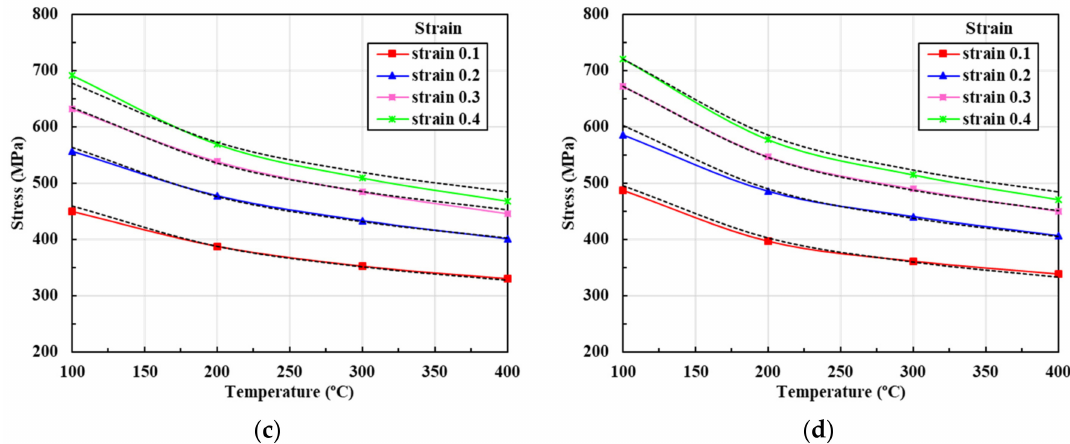
Figure 5. Changes in flow stress with temperature at di ff erent sample strains and strain rates: ( a ) 1 / s; ( b ) 5 / s; ( c ) 10 / s; ( d ) 20 /